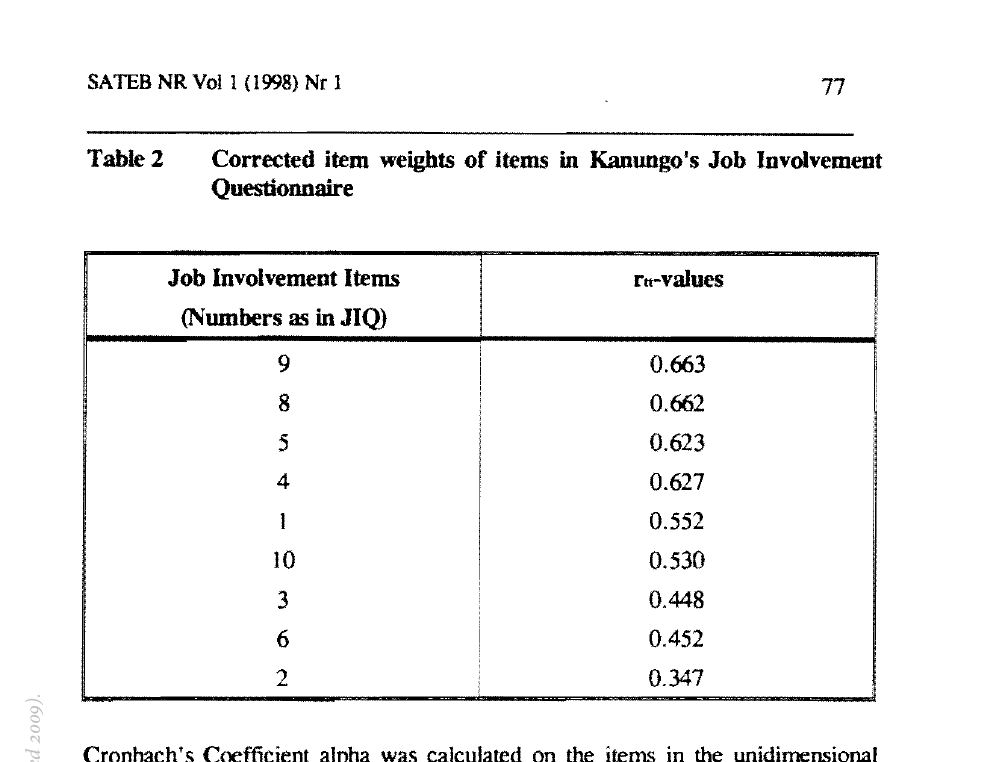
Corrected item weights of items in Kanungo's Job